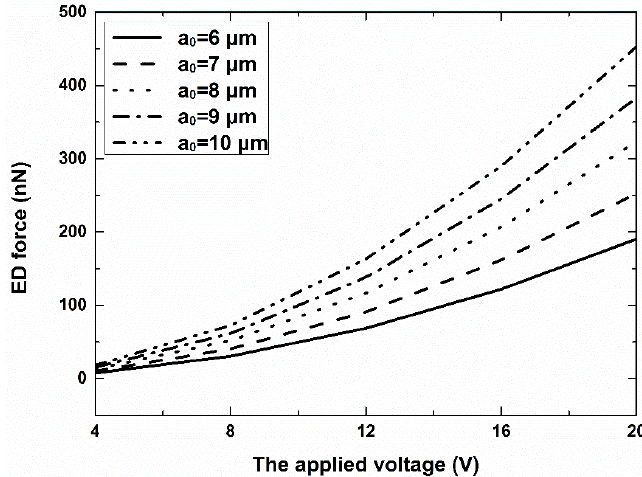
Figure 2. Electro-deformation (ED) forces as a function of the applied voltage and radius of the cell. The applied frequency was 1 MHz.